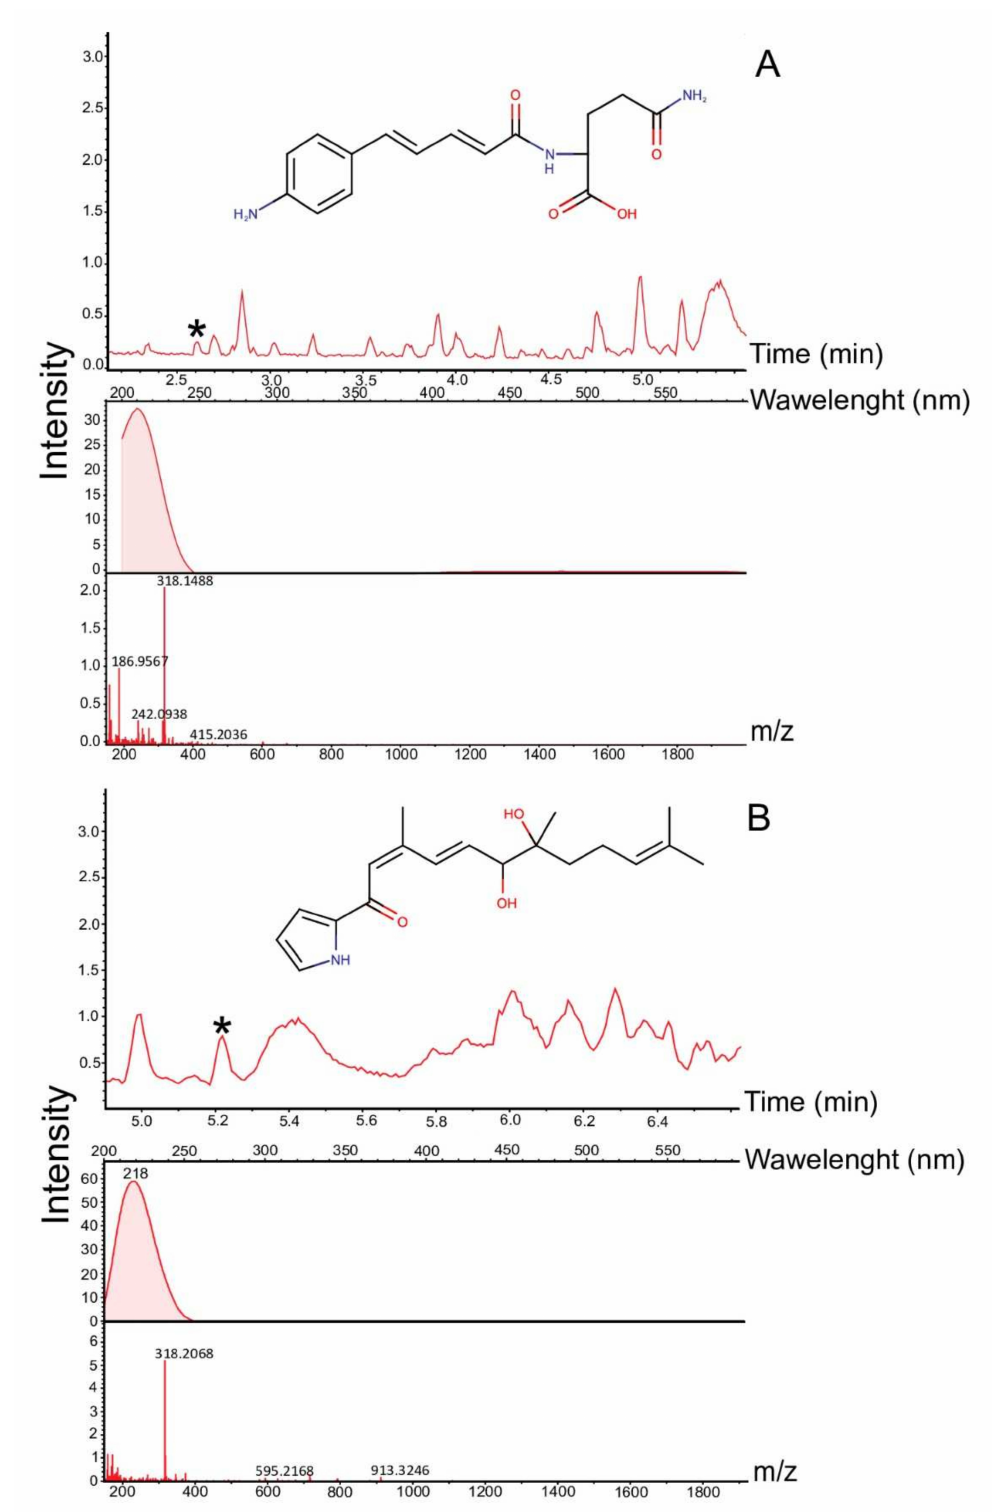
Figure 6. Mass chromatograms of natural products subjected to bacterial destruction: ( A ) MS- chromatogram and MS-spectrum of N2-[5-(4-Aminophenyl)-2,4-pentadienoyl] glutamine; ( B ) MS- chromatogram and MS-spectrum of Glaciapyrrol B. *-asterisks indicate peaks of natural